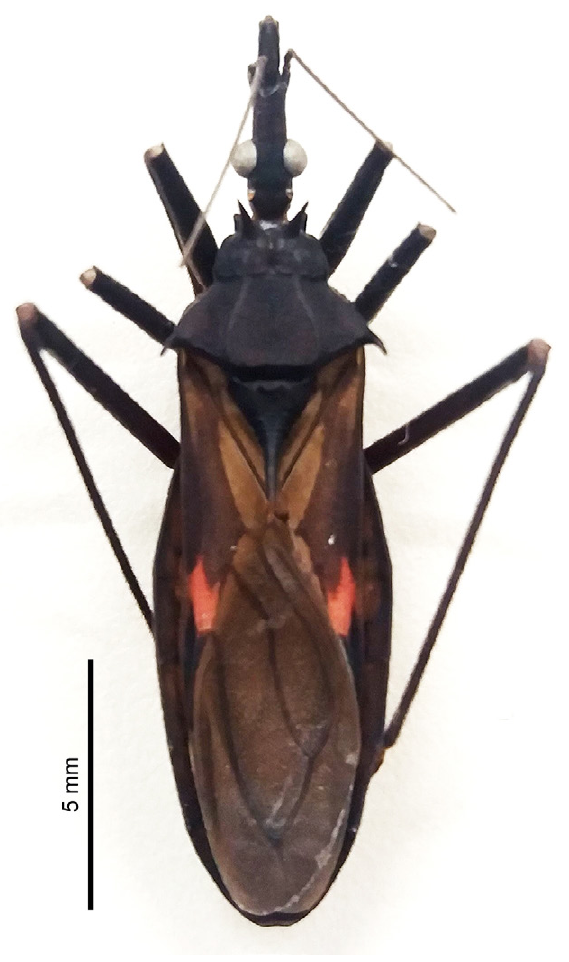
Figure 3. Eratyrus mucronatus Stål, 1859, male, dorsal view. Figure 4. Panstrongylus rufotuberculatus (Champion, 1899), male, dorsal